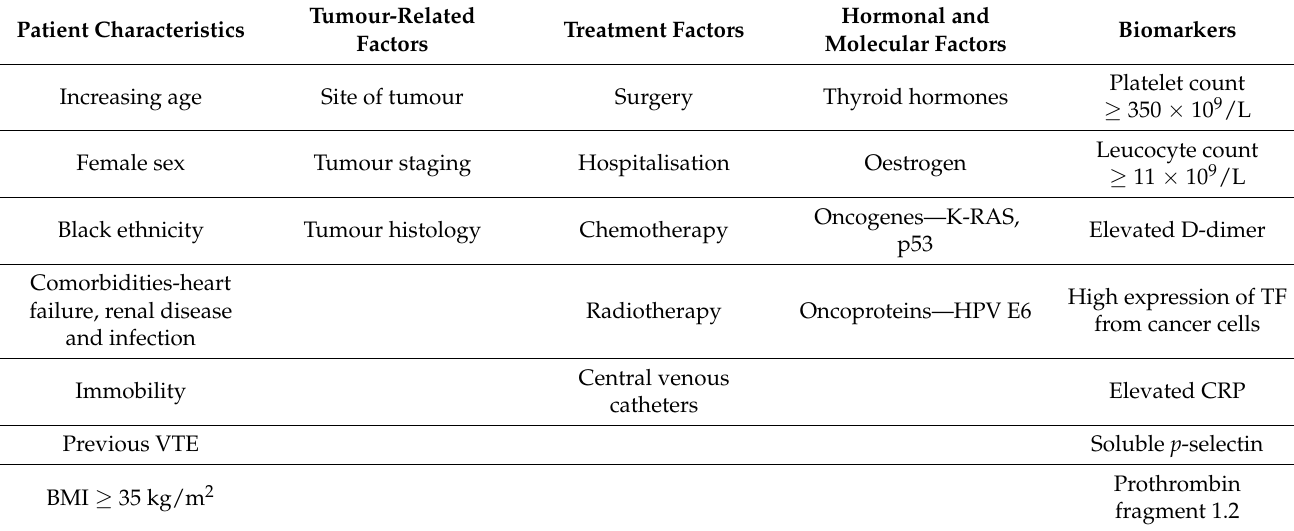
Table 1. Risk factors for cancer-associated